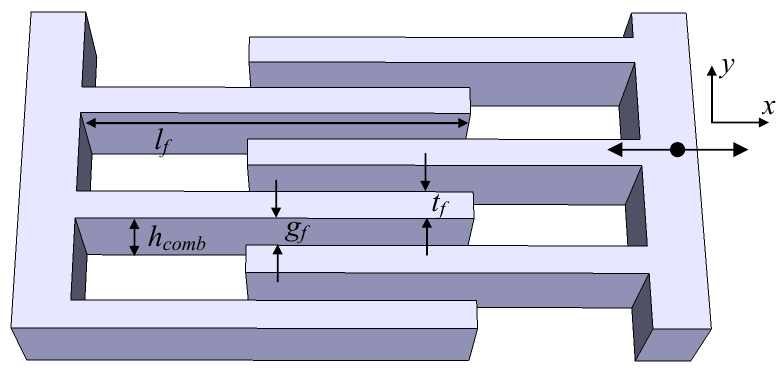
Figure 10. Definitions of structural dimensions in a lateral comb drive, with motion along the